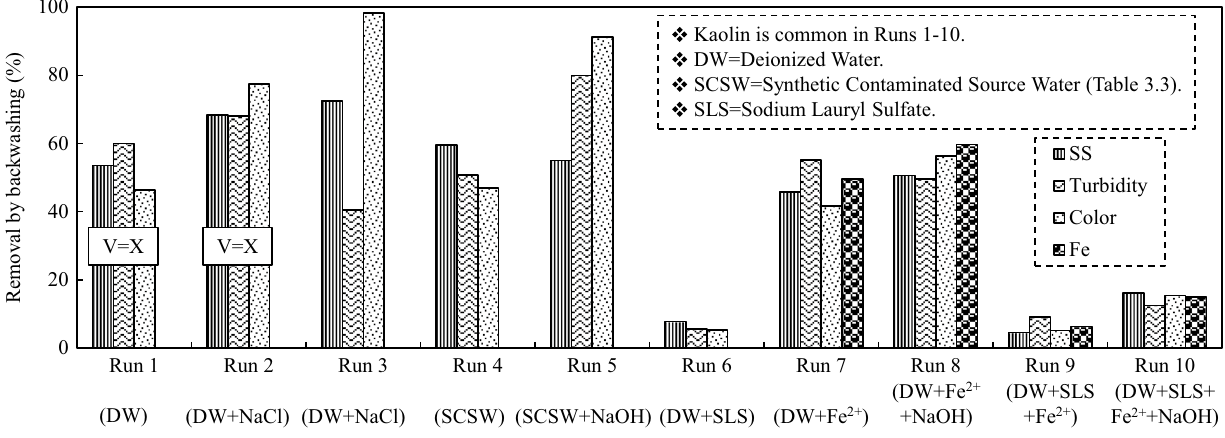
Kaolin is common in Runs 1-10. DW=Deionized Water.